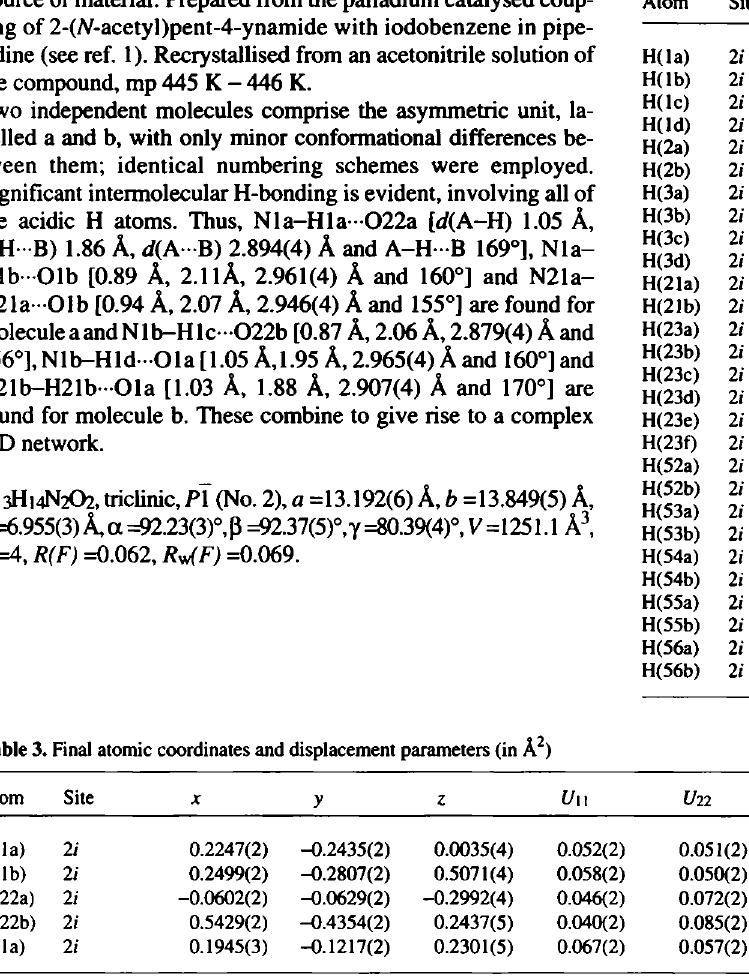
Table 3. Final atomic coordinates and displacement parameters (in